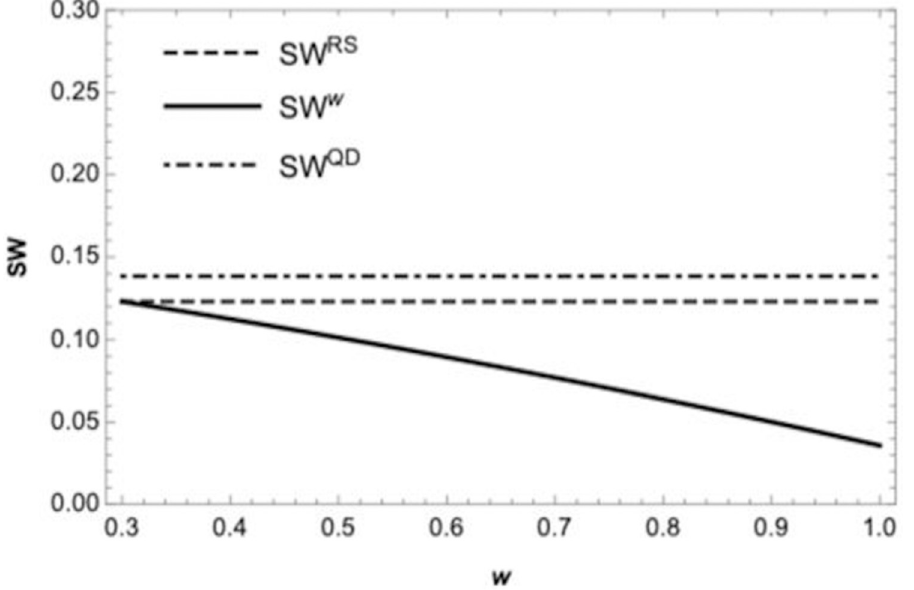
Fig 7. The social welfare under different contracts if the retailer sells in